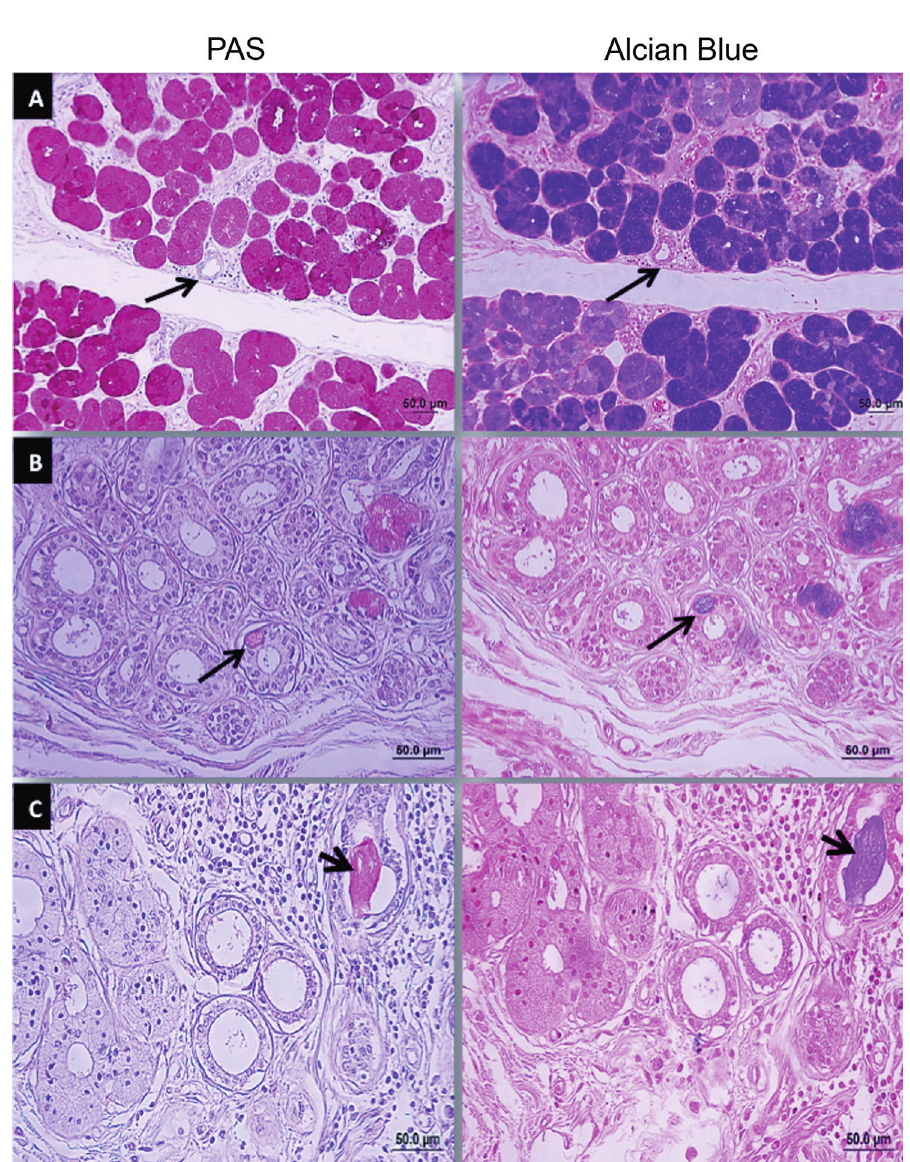
Figure 5- A: Mucous acini stain for periodic acid-Schiff (PAS) and Alcian Blue. The isolated duct-like structures (DLS) is negative for both markers (arrows) – group I (21 years old); B: Partial staining of a DLS for PAS and Alcian Blue (arrows). The most DLS are negative for both markers. Group II (76 years old); C: Negative DLS for PAS and Alcian Blue. Presence of mucus in the lumen of a DLS (arrows). Group II (76 years